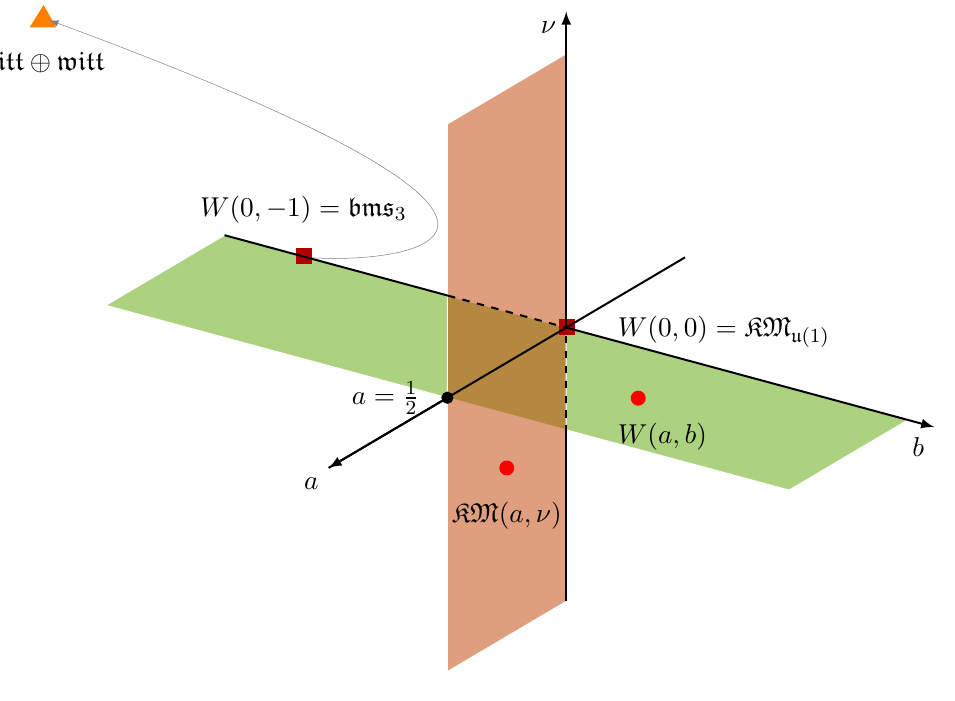
Figure 1 . Parametric space of formal deformations of bms 3 and KM as the formal deformation of both bms 3 and KM in [0 ; 1 = 2] while b; (cid:23) can be any real number. Besides the W ( a; b ), KM KM ( a; (cid:23) ) which is spanned by b = 0 plane. The bms 3 algebra can be deformed to witt (cid:8) witt which again is out of the ( a; b; (cid:23) ) space displayed